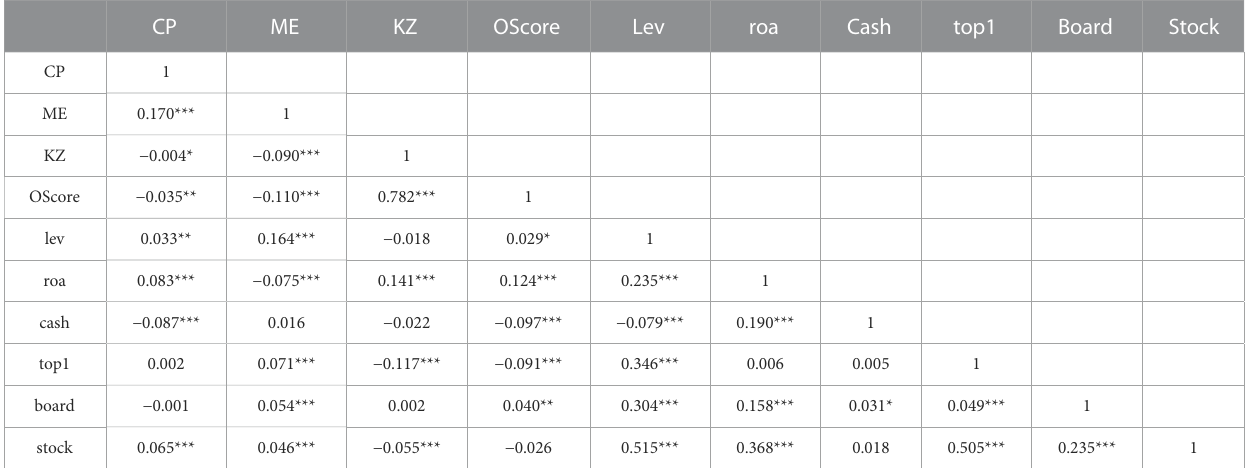
TABLE 3 Correlation analysis.